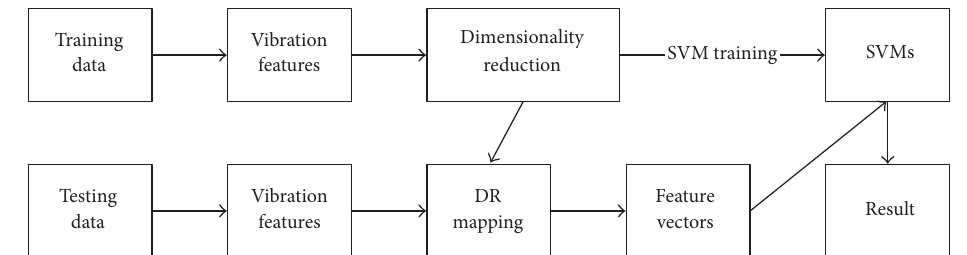
Figure 11: Flow chart of fault diagnosis using DR and SVM.